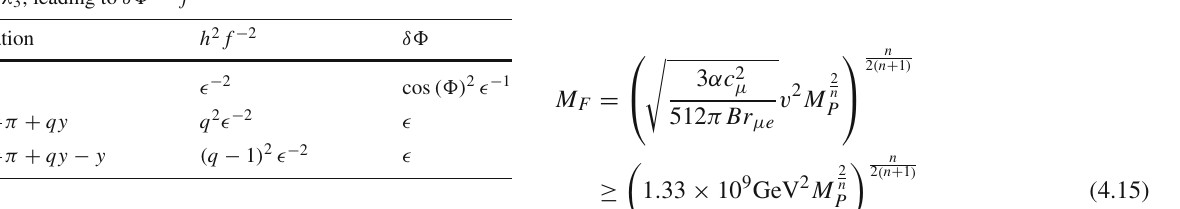
Table 4 Dependence of h 2 f − 2 and δ(cid:9) on the deviation (cid:21) of the pre- sented configurations. Since h 2 f − 2 is always ∼ (cid:21) − 2 , (cid:21) ≈ 10 − 7 is required to generate Br μ e ≈ 10 − 13 − 10 − 14 . Consequently, this would lead to a large δ(cid:9) for the first case, which is not desirable since δ(cid:9) (cid:7) 1 was assumed before. Note that it could be rescued by (cid:9) ≈ π remaining two cases have δ(cid:9) ∼ (cid:21) , thus leading to a very small δ(cid:9) for